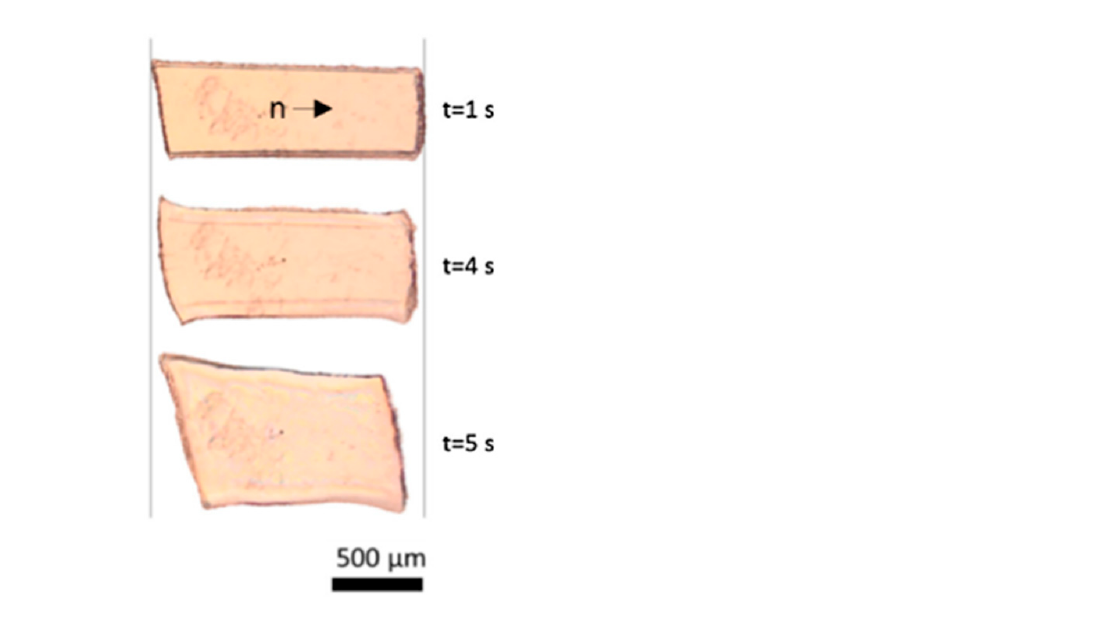
Figure 9. Images taken on an optical microscope show samples with planar alignment, 1, 4 and 5 s following immersion in tetrahydrofuran (THF). Reproduced with permission from Elsevier from Boothby et al.